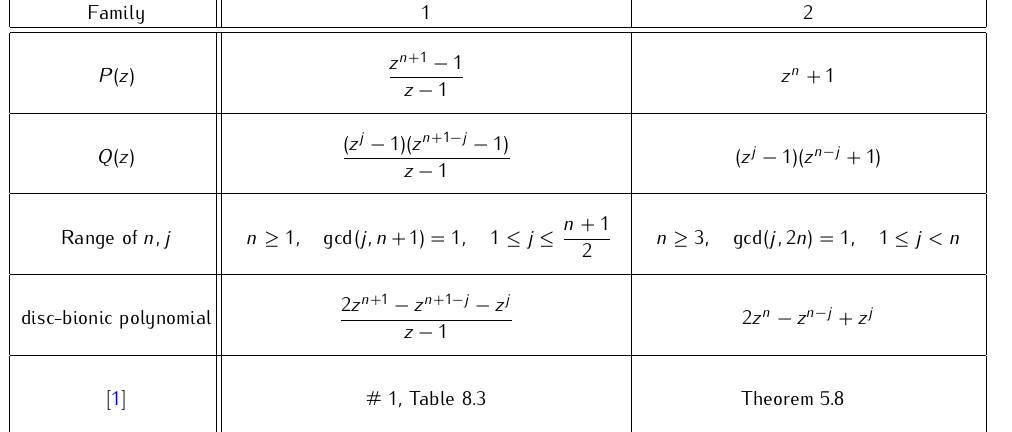
Table 1. The two infinite families of primitive interlacing cyclotomic pairs, with the disc-bionic polynomials associated to them by Theorem 2.1.